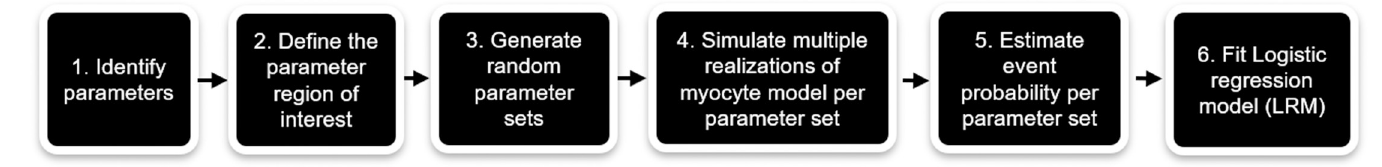
Fig 5. General workflow pipeline for logistic model